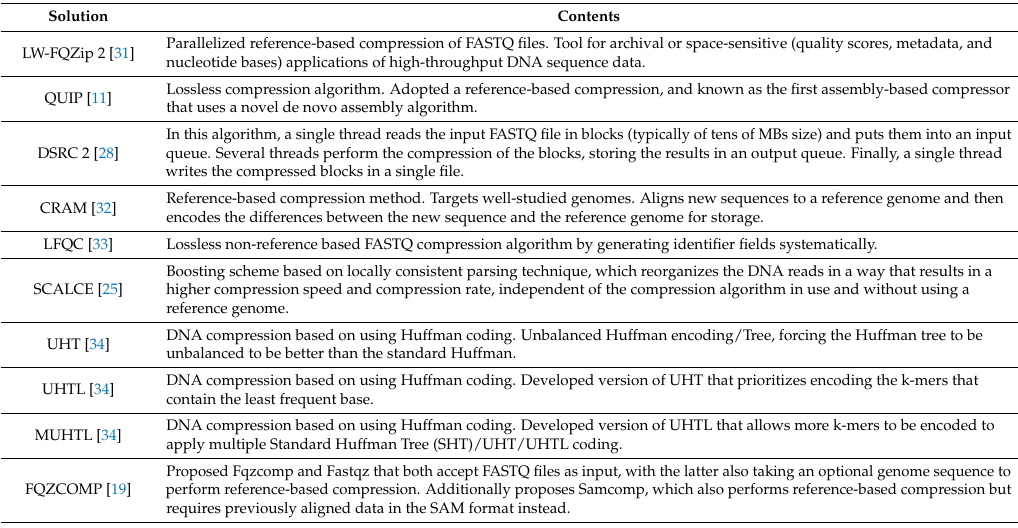
Table 1. Summary of Related